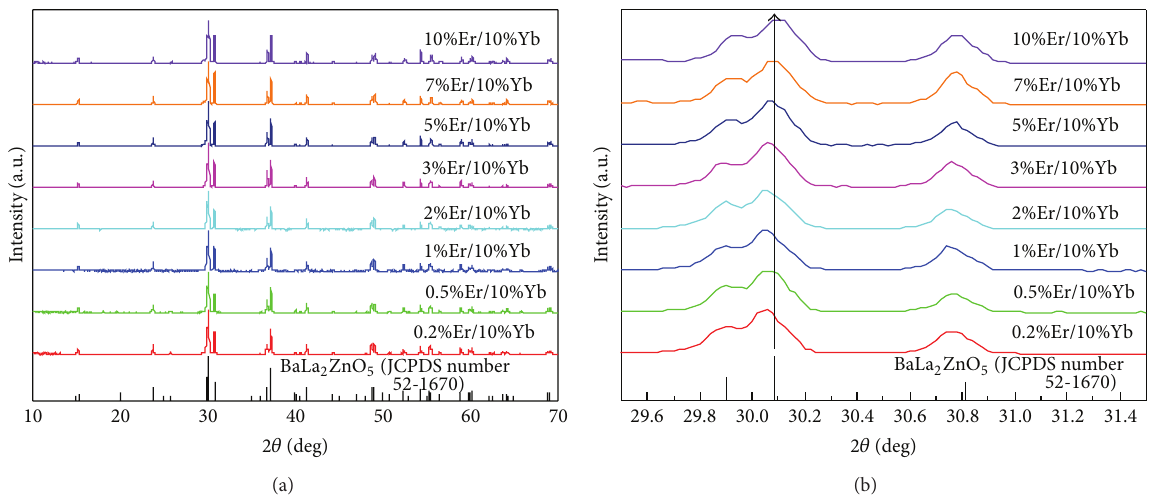
Figure 1: XRD patterns of the BaLa 1.9− ZnO 5 : x %Er 3+ /0.10Yb 3+ ( x = 0.2%, 0.5%, 1%, 2%, 3%, 4%, 5%, 7%, and 10%) and the standard PDF x diffraction lines of BaLa 2 ZnO 5 as a reference: (a) 10 ∘ ≤ 2 𝜃 ≤ 70 ∘ and (b) 29.5 ∘ ≤ 2 𝜃 ≤ 32 ∘